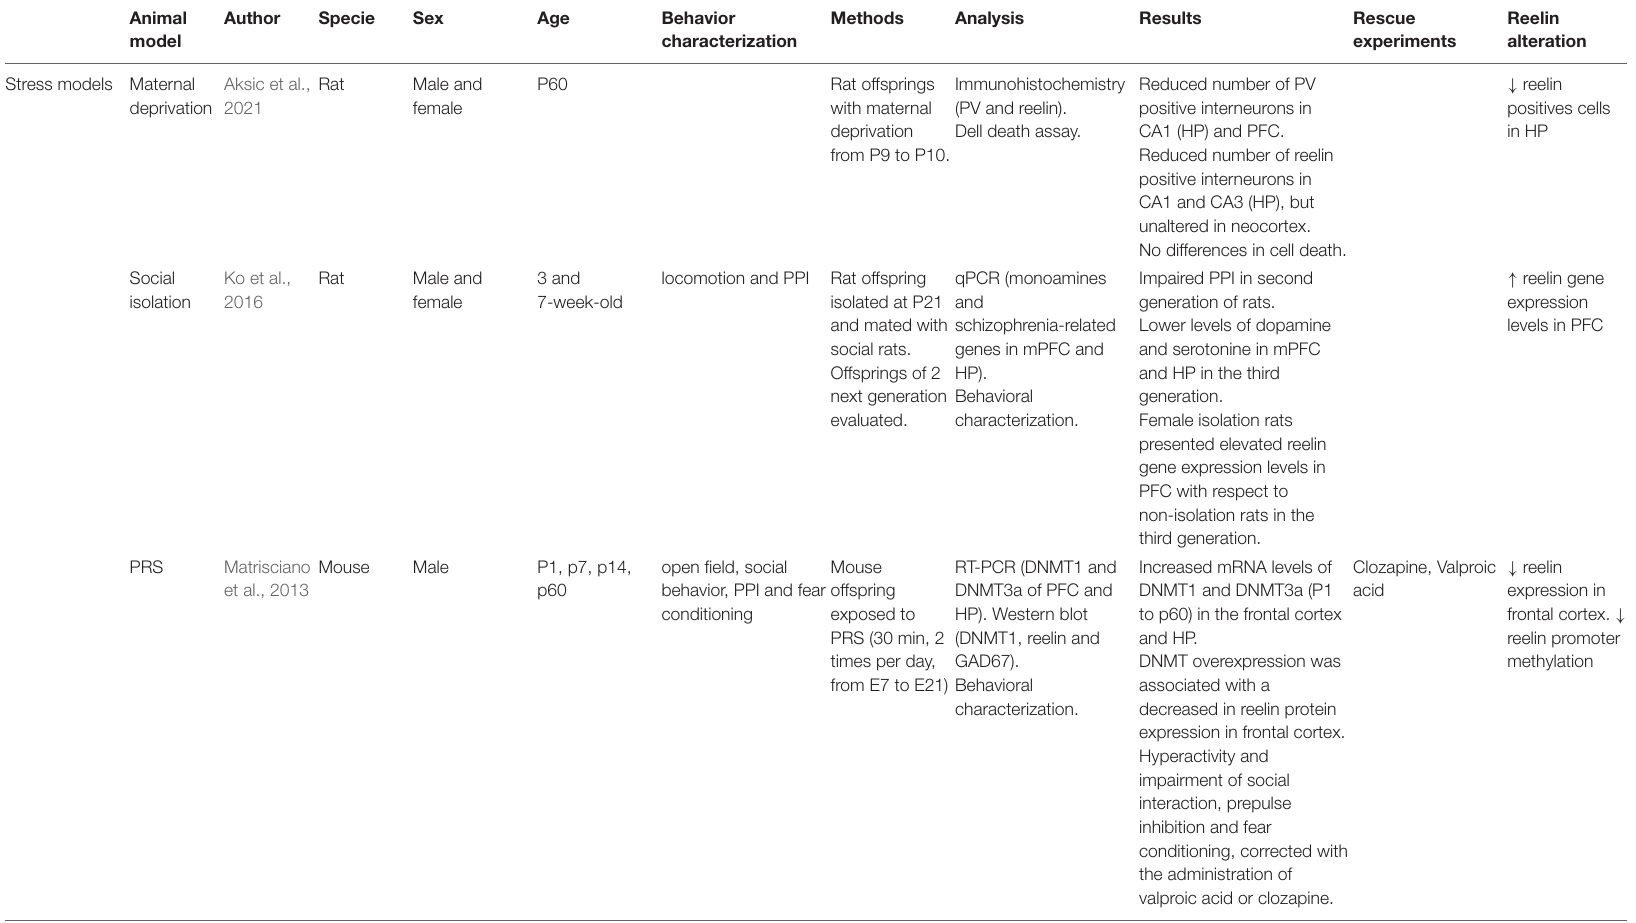
TABLE 3 | Principal findings of stress model studies included in this